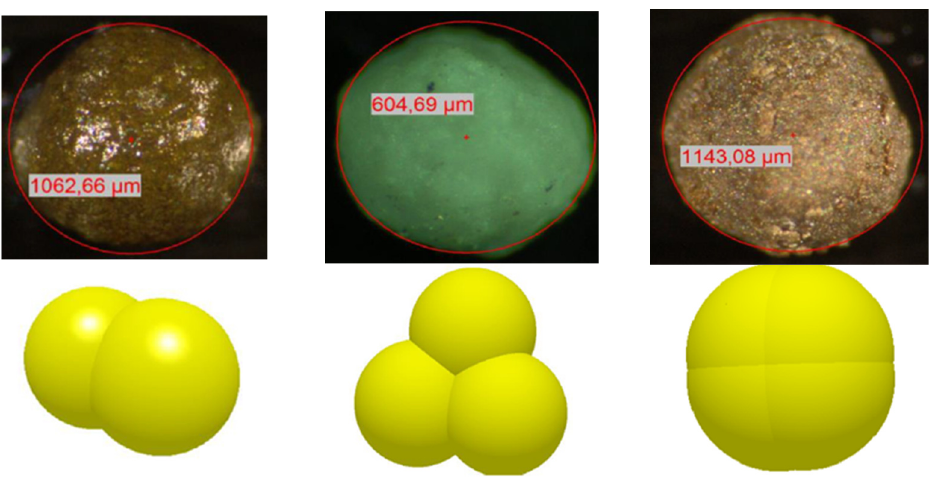
Figure 19. Electron microscopic photos and DEM clumps.